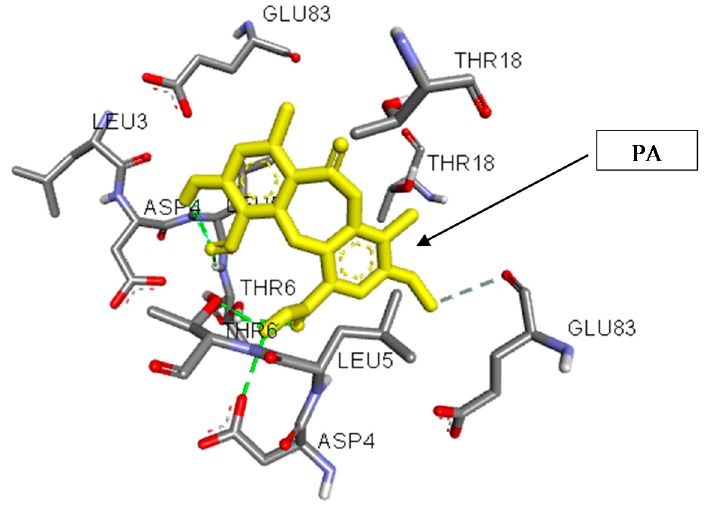
Figure 3. A three-dimensional interaction diagram of psoromic acid (PA) in the active site of arylamine-N-acetyltransferase from M. tuberculosis (TBNAT).